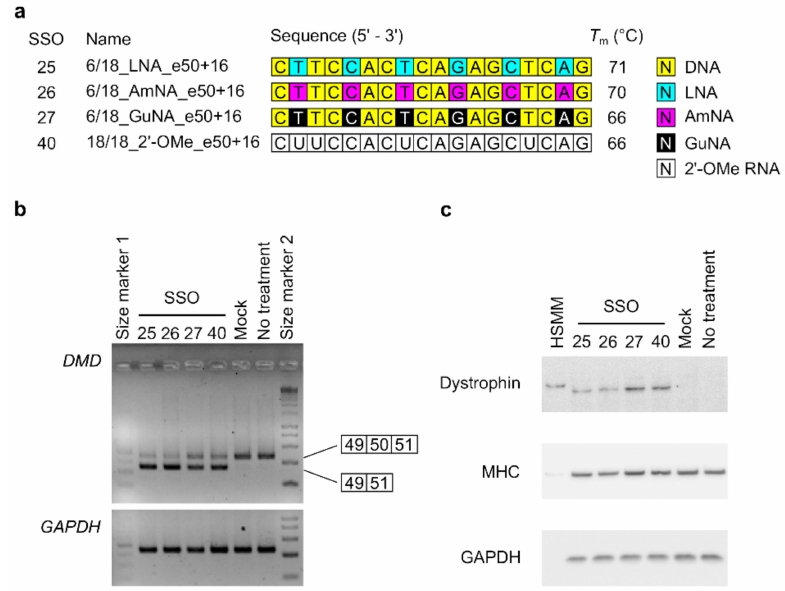
Figure 7. Evaluation of LNA/AmNA/GuNA-modified SSOs for DMD exon 50 skipping at both mRNA and protein levels in DMD model cells. ( a ) Schematic representation of 18-mer SSOs used for the assay. ( b , c ) Results of both RT-PCR and Western blotting analyses. Differentiated DMD model cells were transfected with the indicated SSOs (100 nM). ( b ) RT-PCR analysis shows the full-length ( DMD exon 50 included) upper band (455 bp) and DMD exon 50 skipped lower band (346 bp). GADPH was used as an internal control. ( c ) Western blotting analysis. MHC: myosin heavy chain. Mock: treated with Lipofectamine only; no treatment: no transfection. The analysis was duplicated and repeated three times to ensure